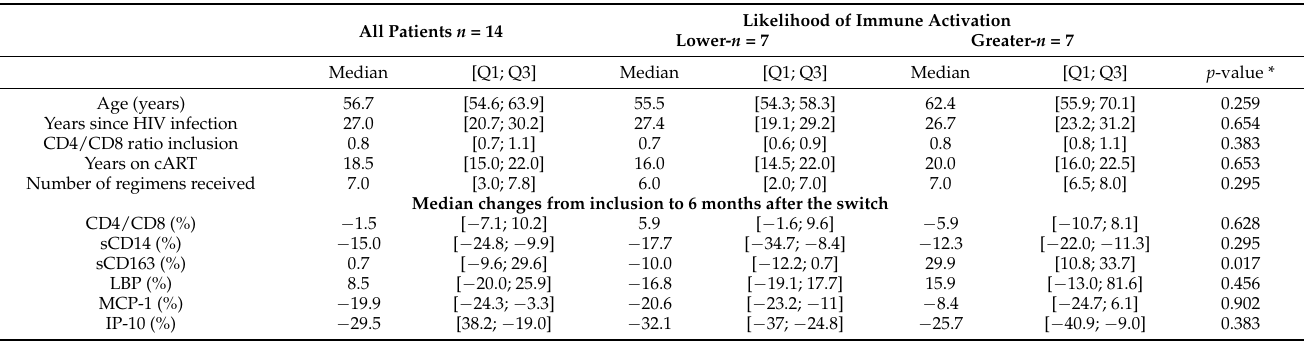
Table 2. Patient characteristics and differences according to likelihood of immune activation. All Patients n =